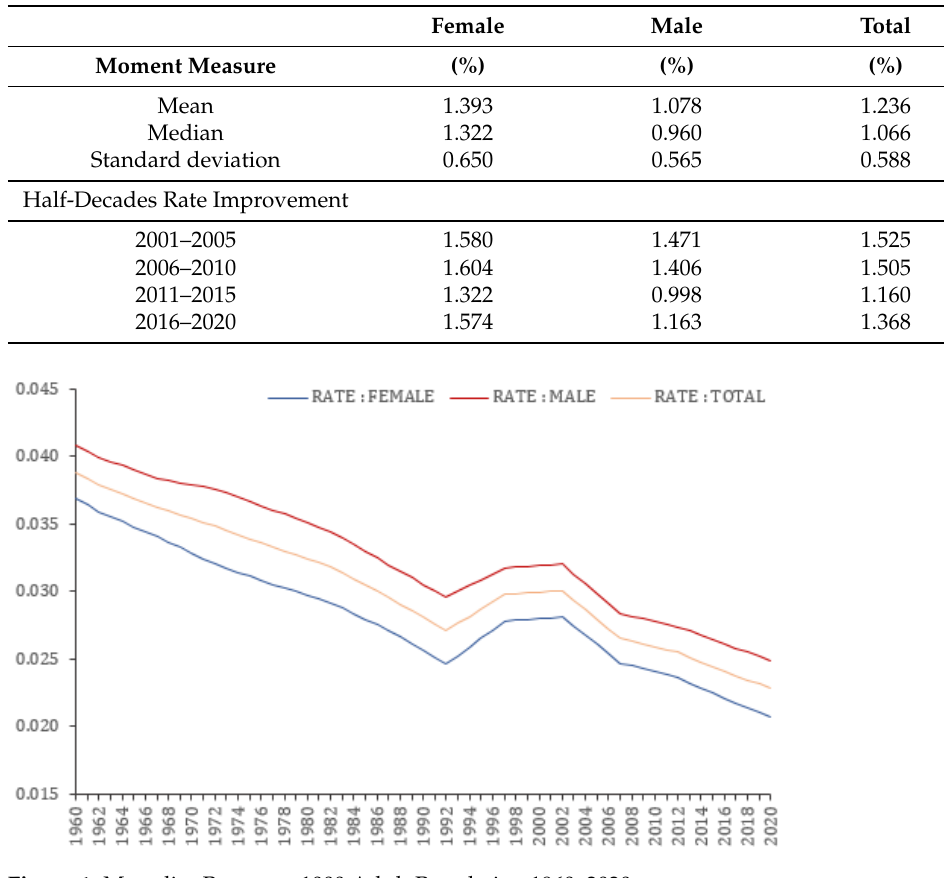
Figure 1. Mortality Rates per 1000 Adult Population 1960–2020.